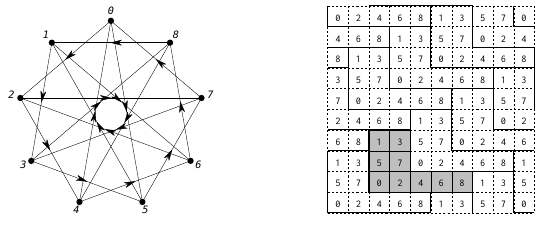
Fig. 1: G (9; 2 , 5) and one related plane